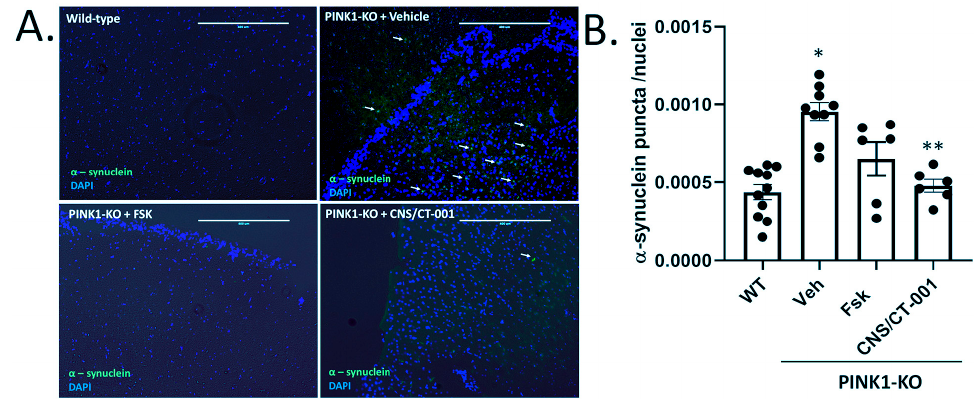
Figure 3. Intranasal delivery of CNS/CT ‐ 001 reverses the amount of α‐ synuclein aggregates in the cortex of PINK1 ‐ KO rats. ( A ) Representative epifluorescence micrographs of brain slices derived from the M3 and M4 region of the cortex from WT or PINK1 ‐ KO rats that were intranasally treated with vehicle control (Veh), with Forskolin (Fsk) or with CNS/CT ‐ 001 for ten days, immunostained for total α‐ synuclein (green) and co ‐ stained with DAPI to label nuclei (blue). The representative arrows point to large α‐ synuclein puncta (green) within neurons. ( B ) Compiled analysis of the mean number of α‐ synuclein puncta per epifluorescence field in cortical brain slices derived from WT or PINK1 ‐ KO rats that were intranasally treated with vehicle (Veh) control, with Forskolin solution (Fsk) or with CNS/CT ‐ 001 for ten days. The data are expressed as the mean number of α‐ synuclein puncta and normalized to the number of DAPI ‐ stained nuclei. Briefly, the data show that intranasal administration of CNS/CT ‐ 001, but not with Forskolin, efficiently reversed the increase in the aggregated α‐ synuclein in the cortex of PINK1 ‐ KO rats to a similar extent as WT rats. Mean ± SEM. *: p ≤ 0.05, Kruskal ‐ Wallis test with Bonferroni correction, n = 8–11 animals per group, *: p < 0.05 vs. WT group; **: p < 0.05 vs. PINK1 ‐ KO/Veh.